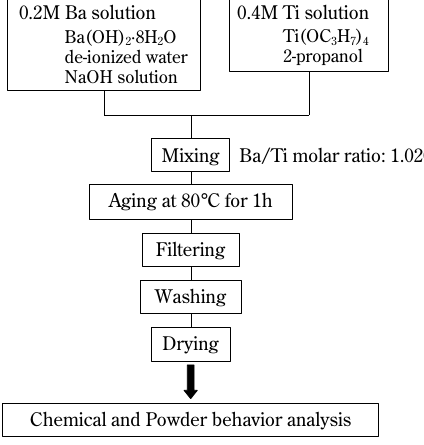
Fig. 1 Flow chart of experimental procedure.